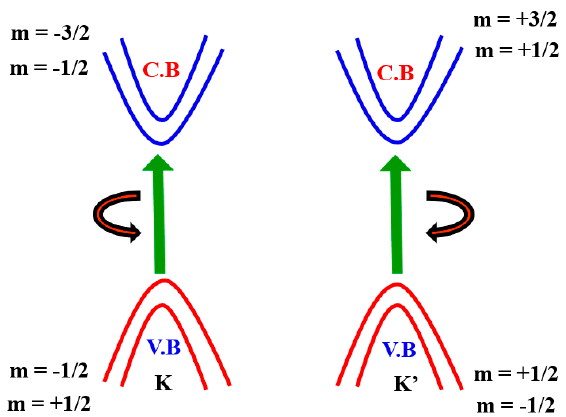
Figure 5. Electronic band structure of spin–orbit interaction around the point K and K’.